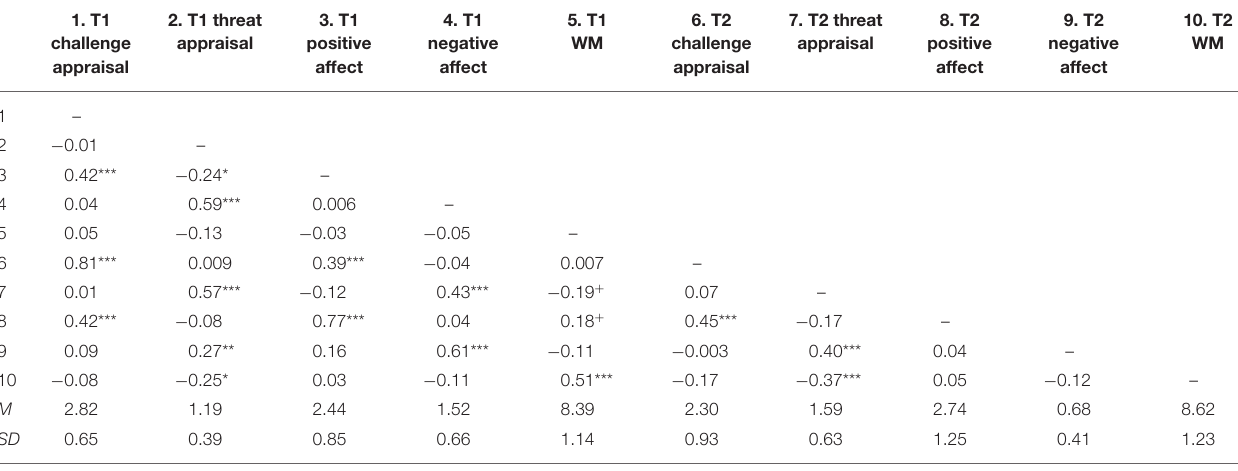
TABLE 2 | Means, standard deviations, and bivariate correlations of main